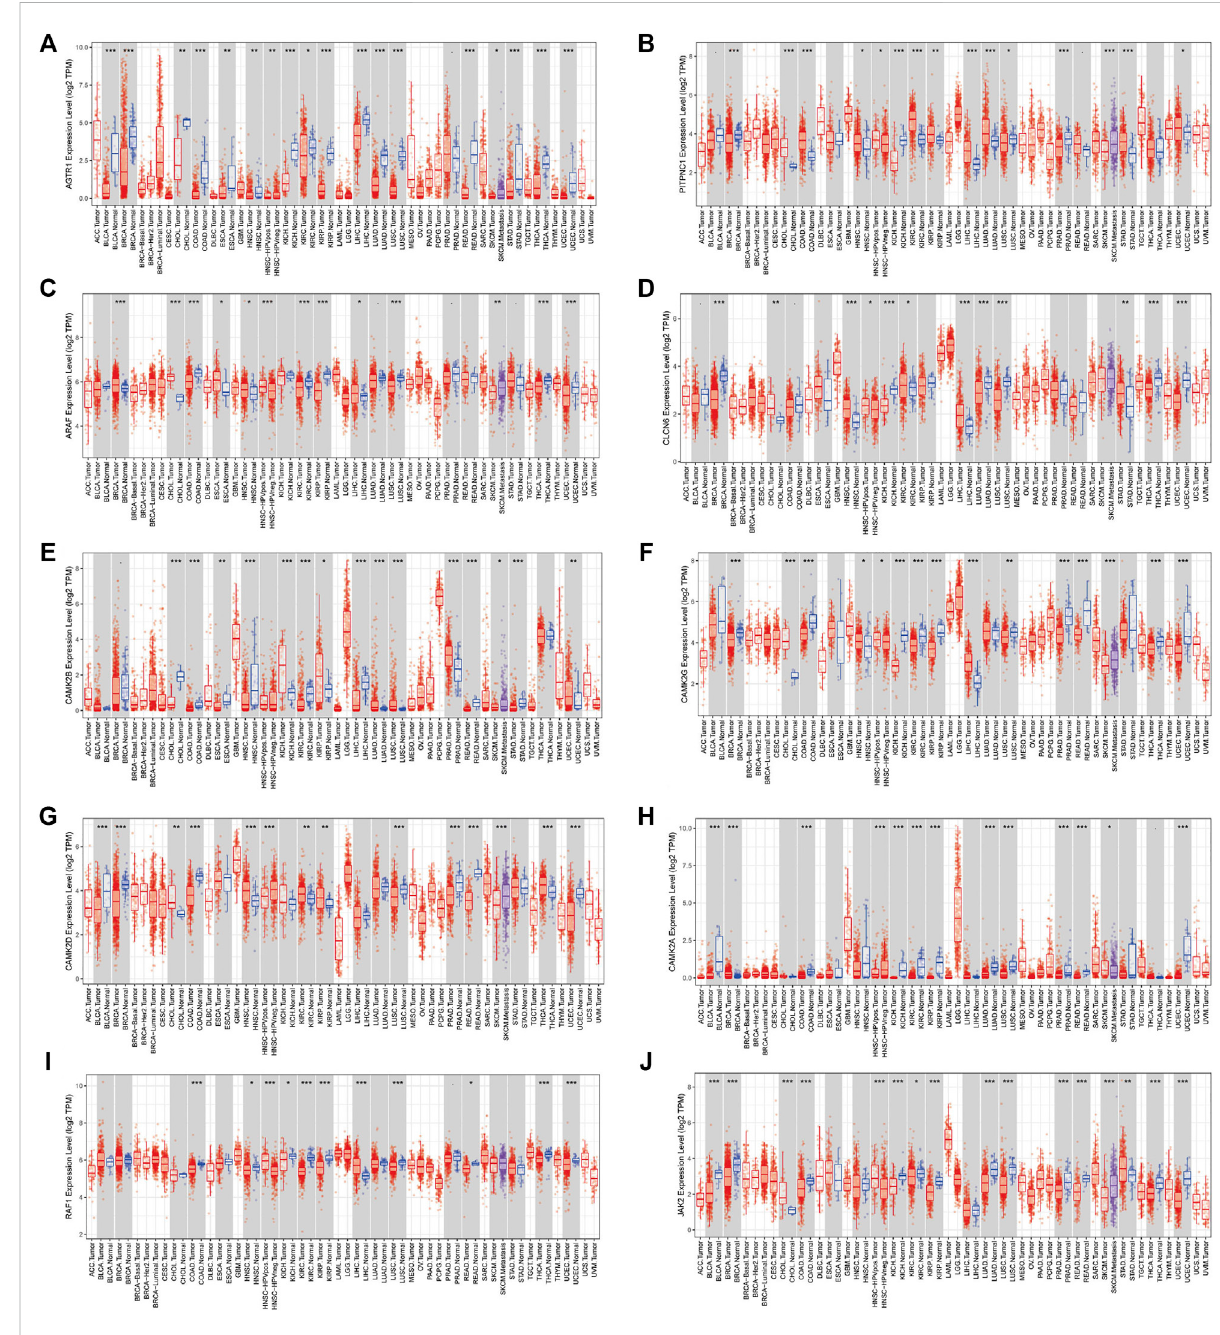
FIGURE 6 Expression of AGTRAP-related genes in pan-cancer. (A) AGTR1. (B) PITPNC1. (C) ARAF. (D) CLCN6. (E) CAMK2B. (F) CAMK2G. (G) CAMK2D. (H) CAMK2A. (I) RAF1. (J) JAK2.